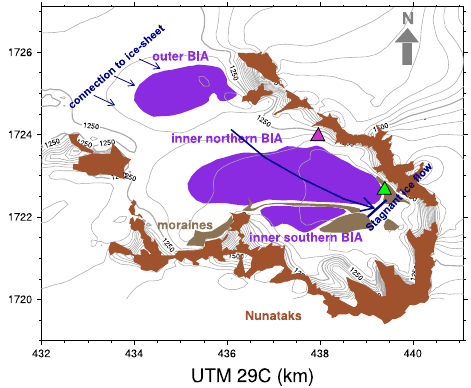
Figure 1. A map of Antarctica is shown at the top right with the domain shown in main image in the boxed area. In the main image, the AWS6 and AWS9 locations are marked and the Scharffenberg- botnen area is enclosed by the box and shown in detail at the top left. Wind tails can be seen generally in a westerly direction from the nunataks, indicating winds from the east. The green triangle on the eastern border of the larger inner BIA shows where a field camp was located before it was destroyed by a storm on 2–3 January 2007, and the magenta triangle shows where one destroyed tent was found after the storm with debris scattered over a wide area of the snow- covered ground. Imagery courtesy of NASA.